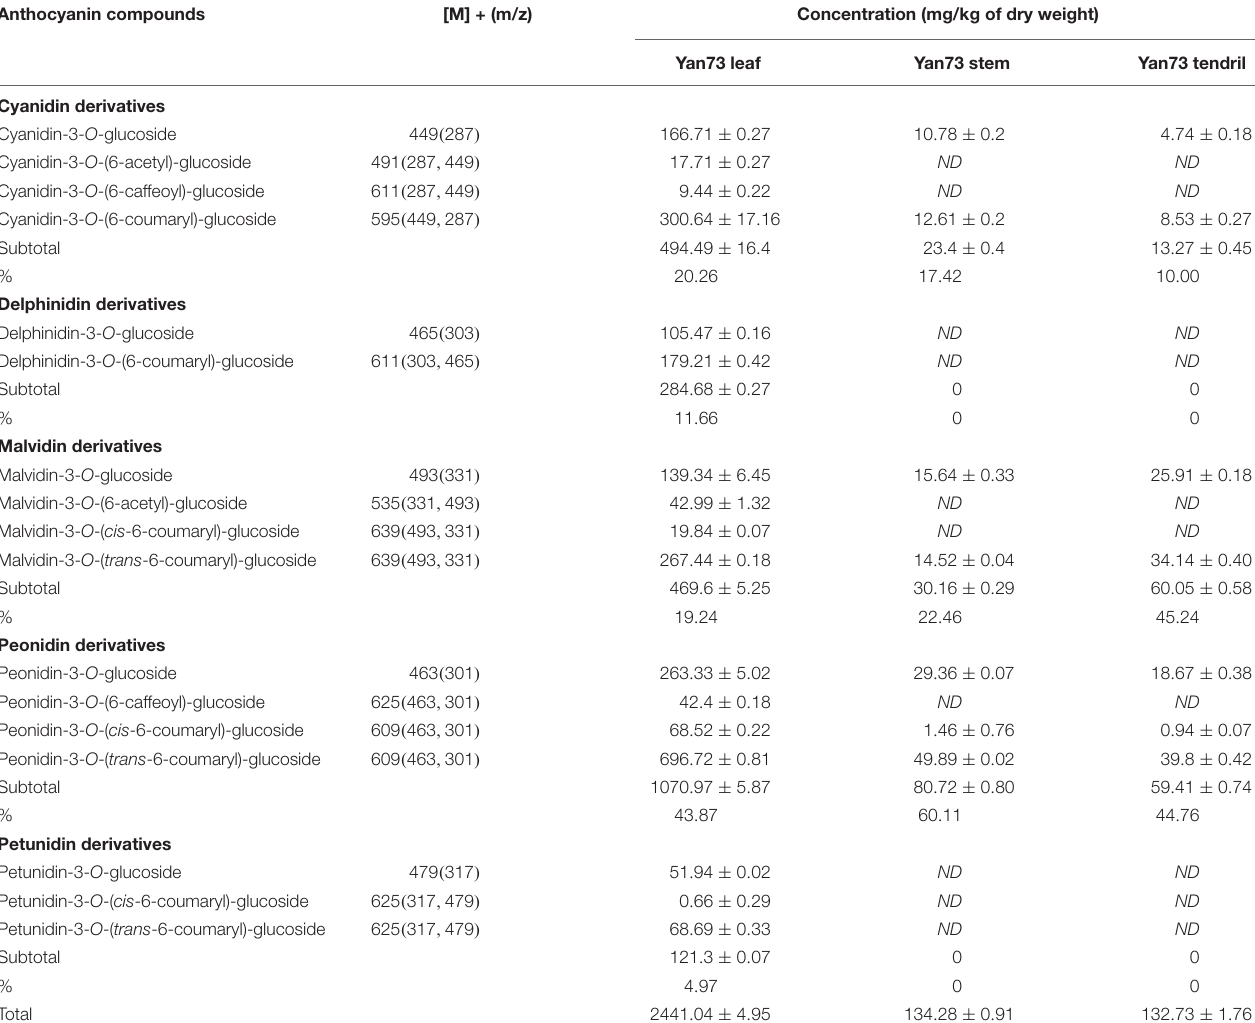
TABLE 1 | Anthocyanin profiles of Yan73 grapevine leaf, stem, and tendril tissues. Anthocyanin